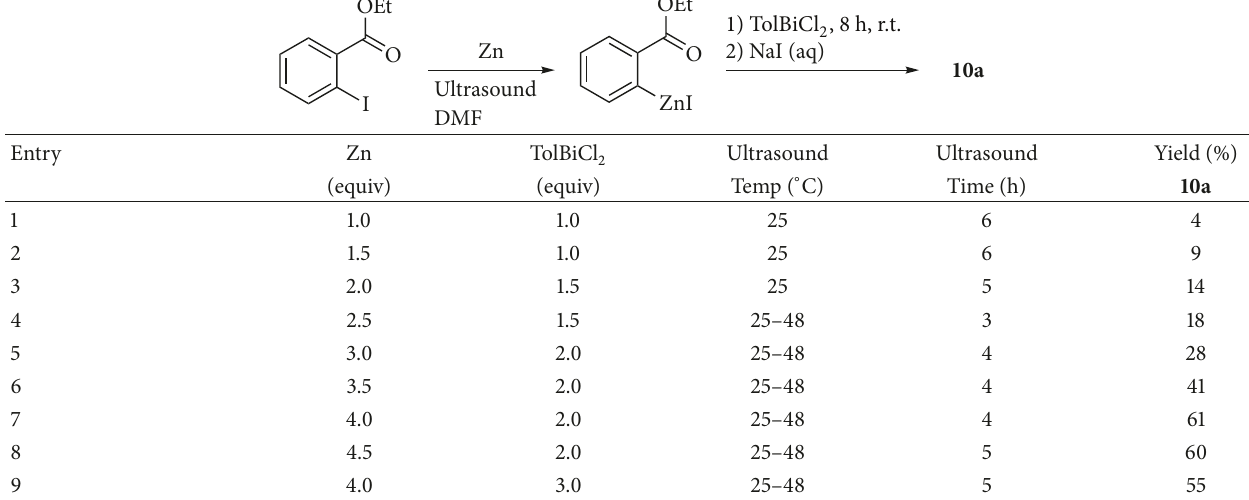
Table 1: Optimization of the reaction conditions for the synthesis of 10a .